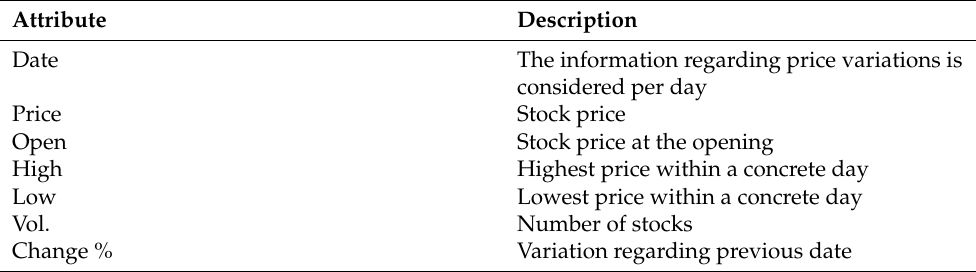
Table 2. Stock market price variation. Source: Stock market for the symbol CZ.